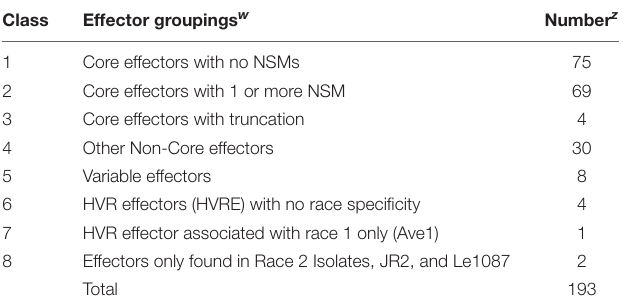
TABLE 2 | Unique effector-like regions discovered through filtering coding sequences through SignalP and EffectorP. Coding sequences were extracted from mapping reads from 18 V. dahliae genomes to the JR2 reference genome (ASM15067v2).